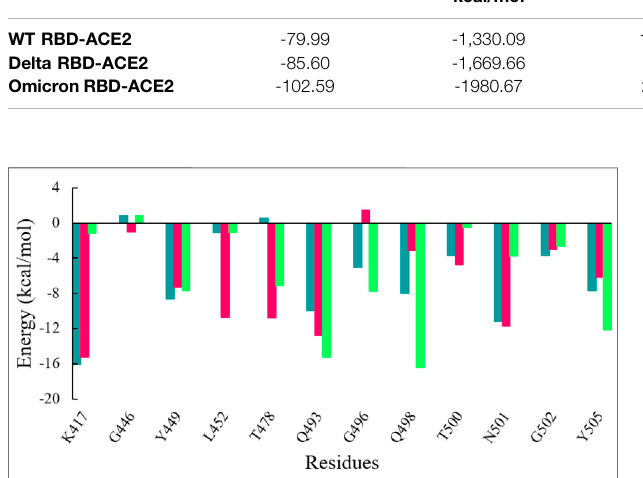
TABLE 2 | Contribution of individual energy component in the binding of SARS-CoV-2 WT, Delta, and Omicron with the human ACE2 receptor. Complex vdW kcal/mol Electrostatic kcal/mol